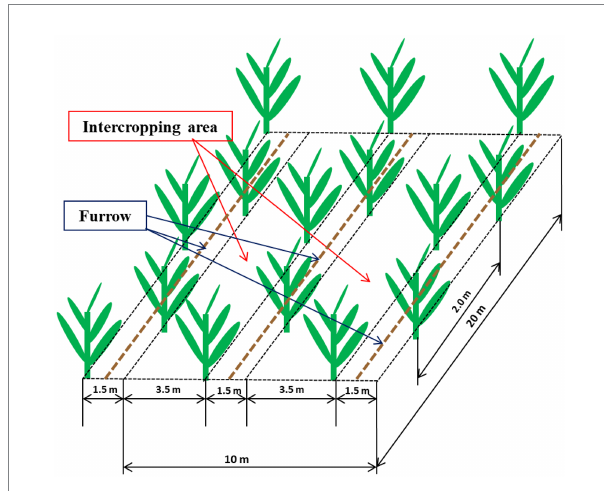
FIGURE 1 Diagram showing the 3.5 m intercropping area and 1.5 m furrow containing the banana plants within an individual